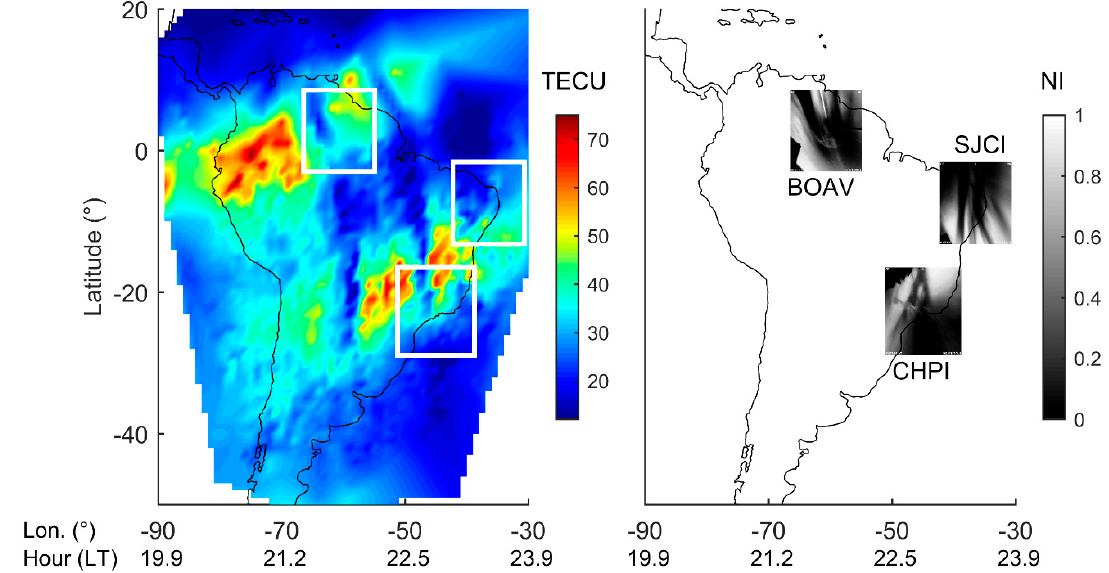
Figure 2. Comparative example between the Vertical Total Electron Content (VTEC) depletions and the dark brands of the airglow observations. The white square shows the exact location of the Geo- referenced OI 630 nm images and the grayscale is in units of normalized intensity (NI).